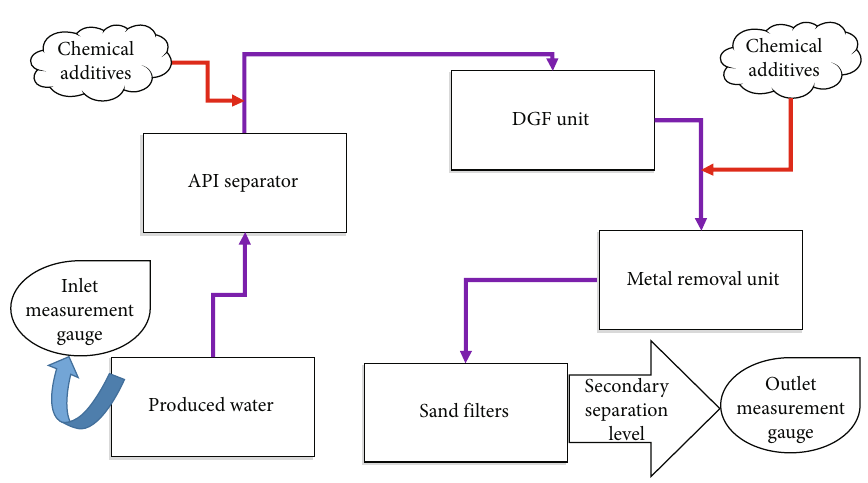
Figure 1: Separation process for water treatment process. Table 1: Treated fl ow-back water at di ff erent stages based on MM m 3 for one day in hydraulic fracturing